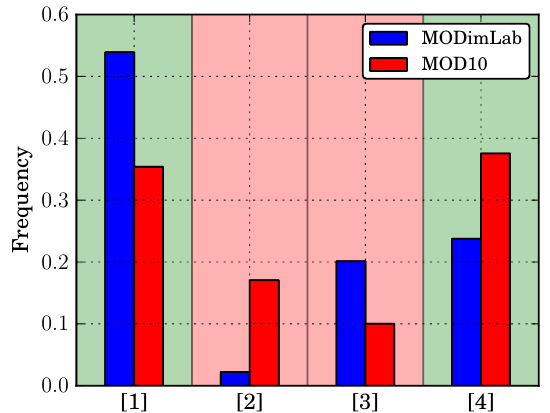
Figure 6. Frequency of occurrences of hit rate and confusions in the classification of clouds by MODImLab ( n = 13312 pixels) and MOD10 ( n = 3328 pixels). Reference data were obtained via visual interpretation of clouds in simultaneous ASTER images. Category 1 corresponds to cloudy pixels detected as cloudy pixels, category 2 to cloudy pixels detected as cloud-free pixels, category 3 to cloud- free pixels detected as cloudy pixels and category 4 to cloud-free pixels detected as cloud-free pixels. Categories 1 and 4 correspond to the correctly classified pixels (green background) and categories 2 and 3 correspond to the misclassified pixels (red